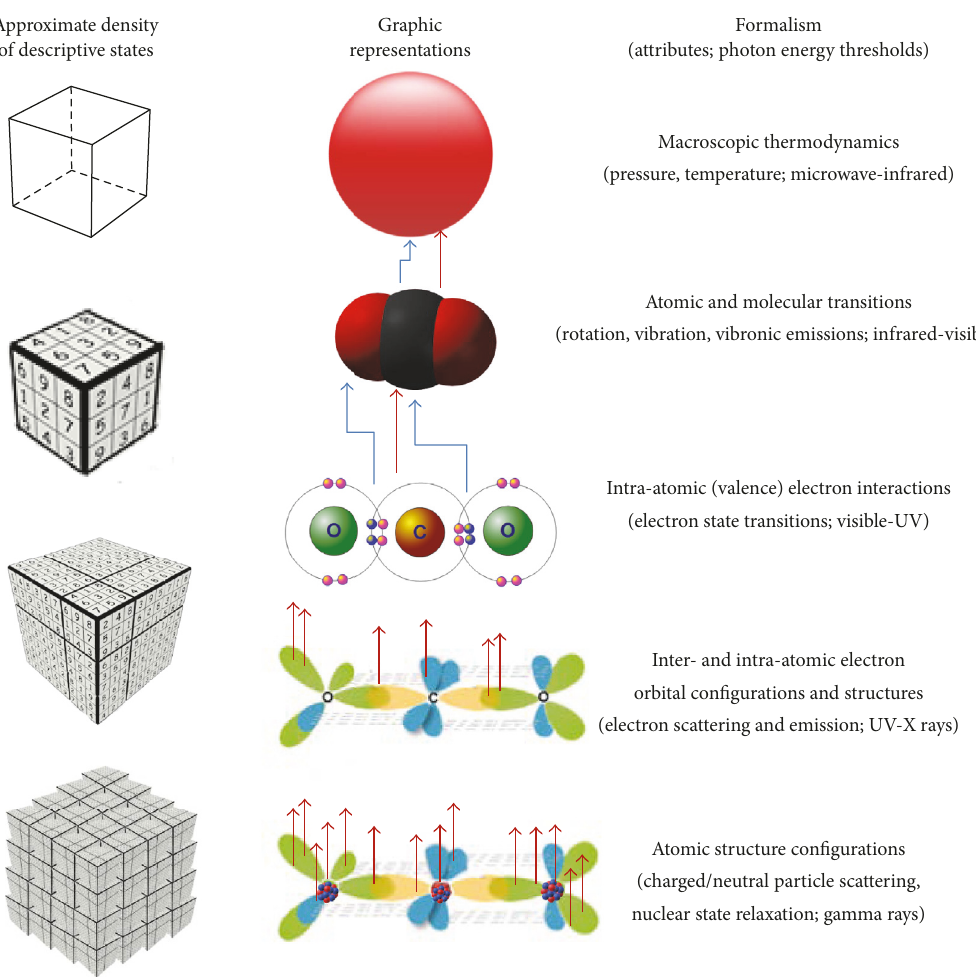
Figure 3: A depiction of different kinds of descriptive levels of carbon dioxide molecule behavior, arranged by energy thresholds. The use of morepowerful, lower object level energy inputs is associated with thedisruptionof objects at finer scales of resolution that make up molecules, atoms, and subatomic particles. The perturbation of finer scale structures necessitates accounting for higher numbers of states representing higher object densities, along with formalisms for functions and relationships particular to each